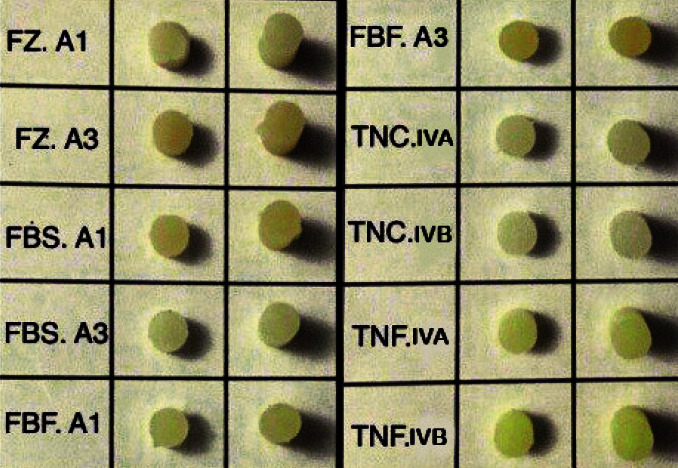
 Resin composite samples